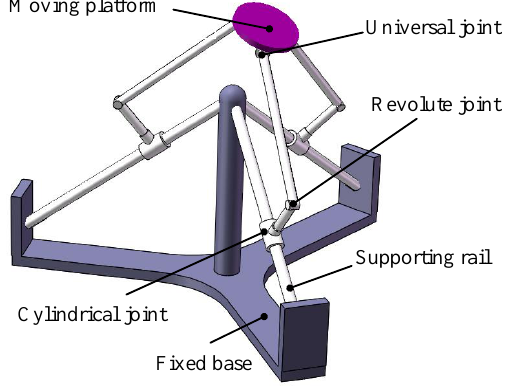
Figure 2. The modified 3-CRU